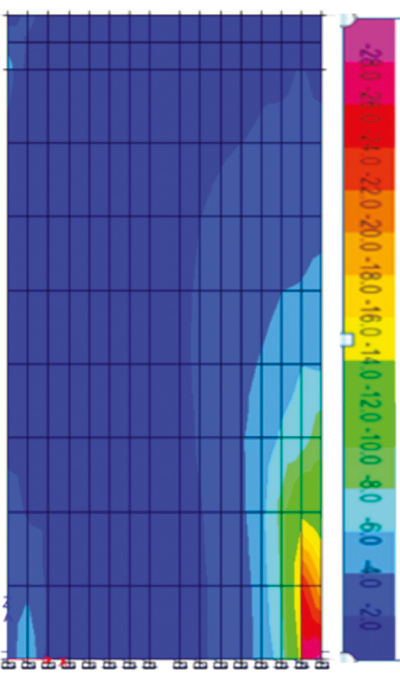
Figure 22: Constitutive models of concrete and steel bar. Figure